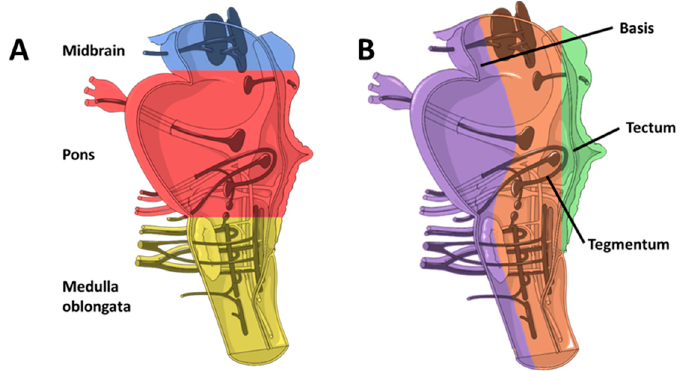
Figure 1. Anatomical structures of the brainstem showing cranial nerves. ( A ) The brainstem is divided into the Midbrain (blue), Pons (red), and the Medulla Oblongata (yellow). ( B ) Laminae of the brainstem: Basis (purple), Tegmentum (brown), and Tectum (green). Schematic modified from [54].